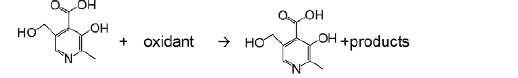
Scheme 2. Standard redox potentials of